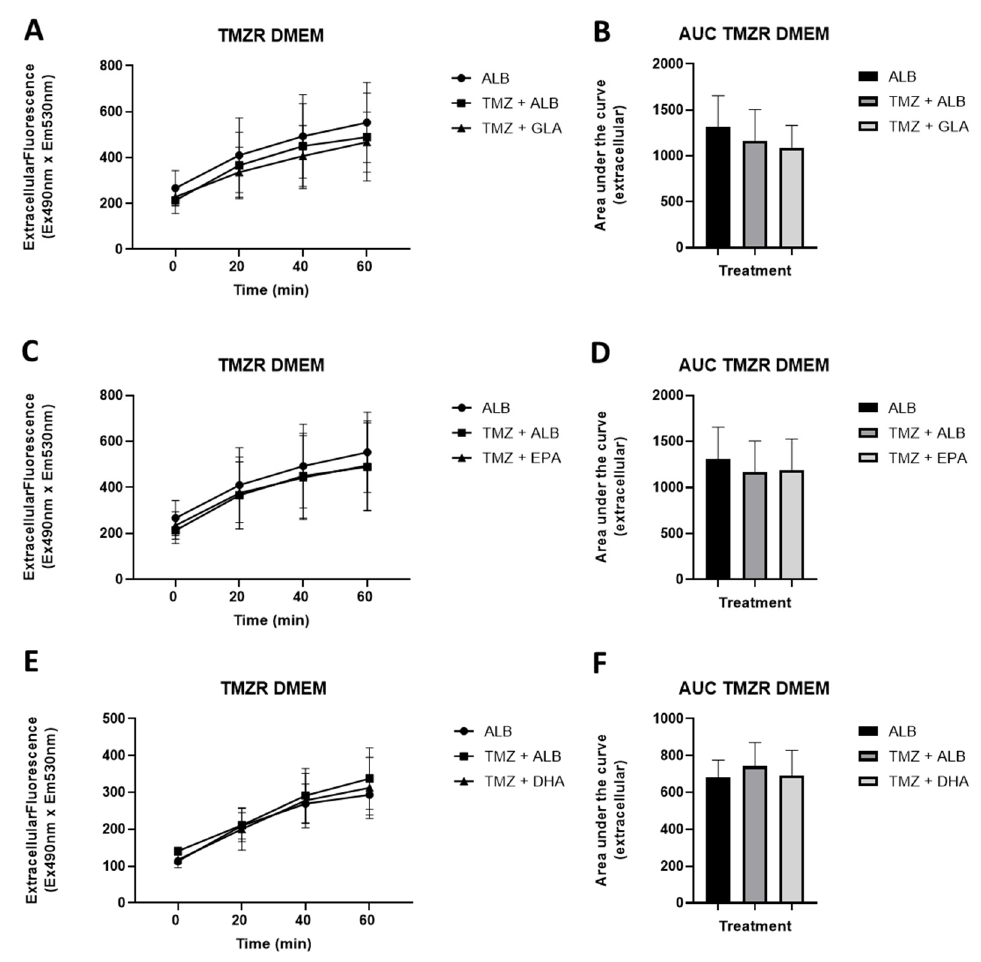
Figure 12. Effects of gamma-linolenic acid (GLA), eicosapentaenoic acid (EPA), and docosahexaenoic acid (DHA) on rhodamine 123 efflux in TMZR cells: ( A ) Efflux ± GLA. ( B ) Area under curve for efflux ± GLA. ( C ) Efflux ± EPA. ( D ) Area under curve for efflux ± EPA. ( E ) Efflux ± DHA. ( F ) Area under curve for efflux ± DHA. Data are presented as mean ± SEM, N = 3. Differences were considered significant at p < 0.05.